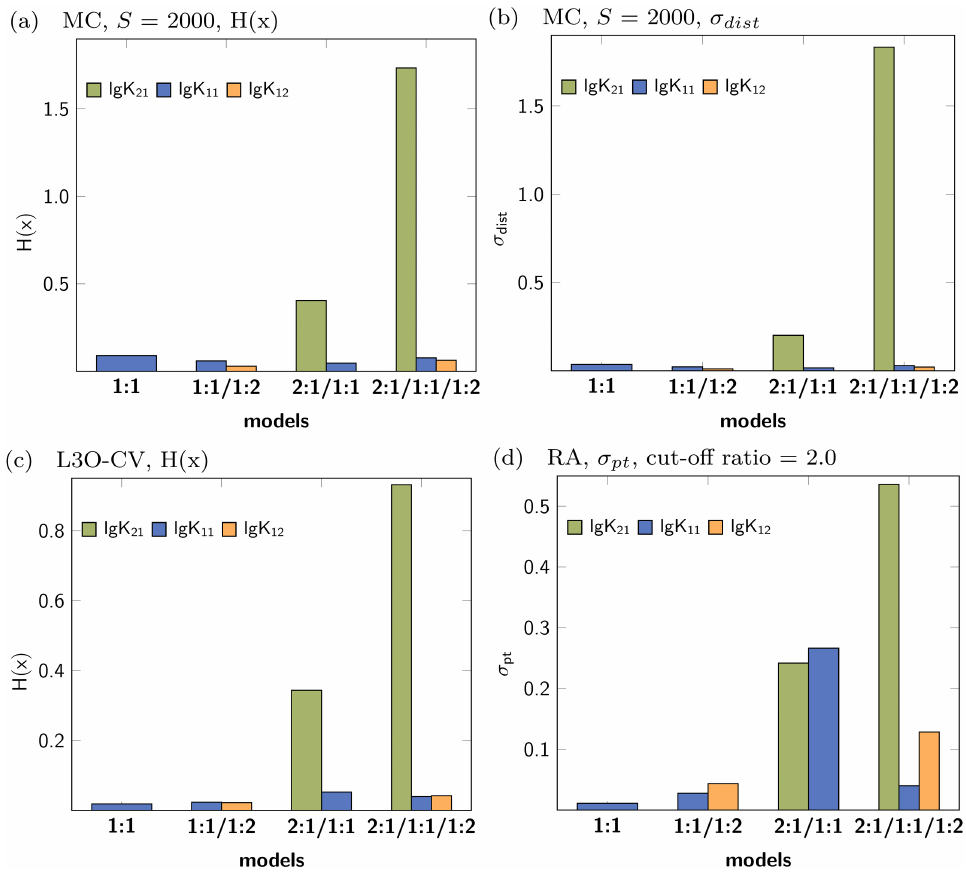
Figure 11 Calculated statistical descriptors for four models (A–D) obtained after Monte Carlo simu- lation, Leave-3-Out Cross Validation and Reduction Analysis performed on a simulated NMR titration with a 2:1/1:1/1:2 model. Full-size DOI: